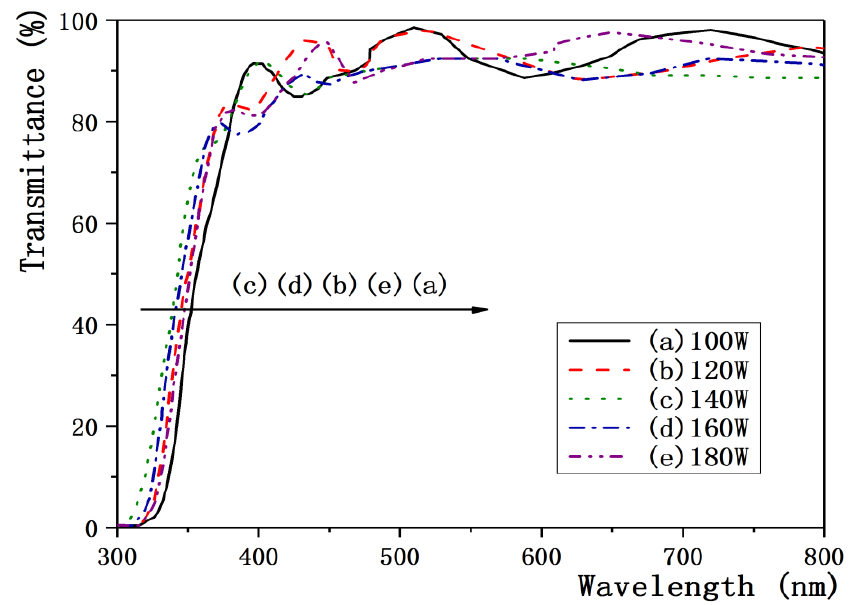
Figure 5. Transmission spectra of ZnO:Ga films prepared at di ff erent sputtering power [75]. Table 2. The performances of ZnO:Ga films produced at di ff erent sputtering power [75]. Sputtering